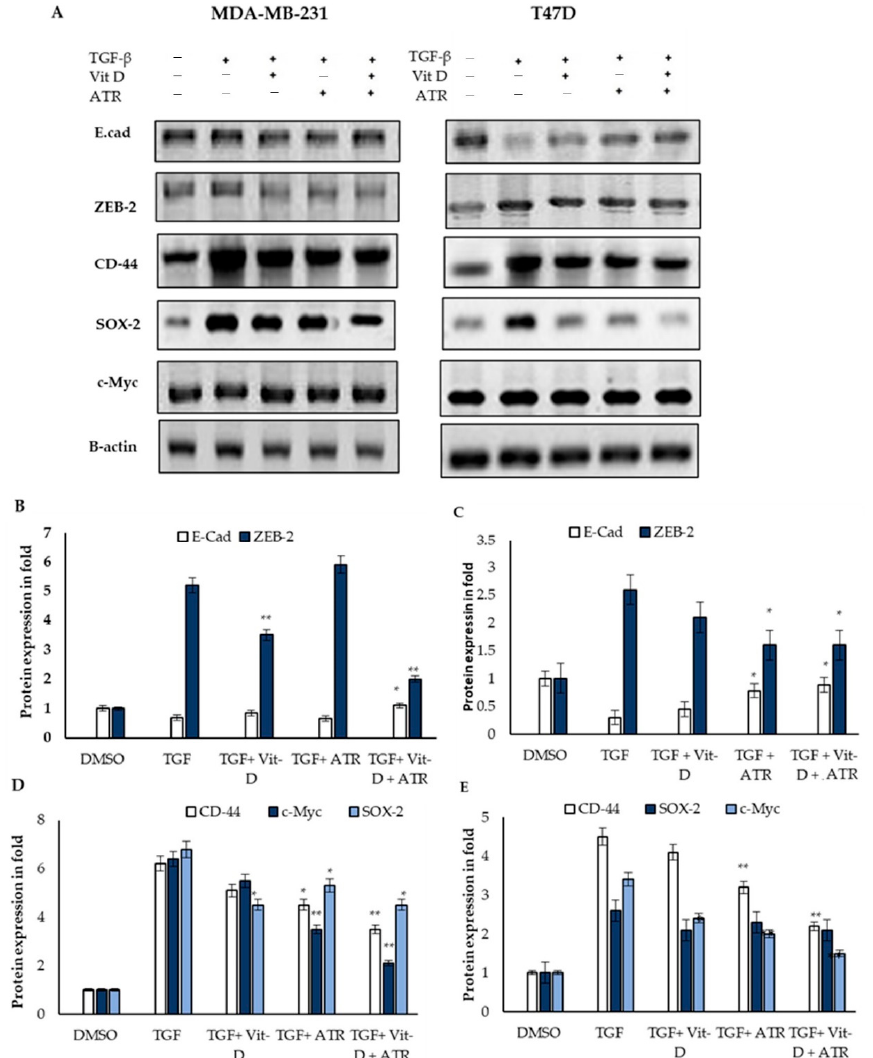
Figure 5. The expression of breast cancer mesenchymal modification proteins is modified after atropine treatment. The MDA-MB-231 and T47D breast cancer cell lines were cultured in the presence of DMSO or TGF- β (10 ng/mL), the latter having been treated with vit D (10 nM) or vit D and atropine. As a protein internal control, 3A β -actin (actin) was used. Representatives immunoblot ( A ) and protein quantification ( B – E ) of E-cad, ZEB-2, CD-44, SOX-2, and c-Myc were estimated after 48 h of treated conditions seen above. Results are shown as mean ± SD from a representative experiment out of three independent experiments studied in quadruplicates and produced similar results. * p < 0.05 and ** p < 0.01 (one-way ANOVA); horizontal bars denote statistical comparisons.